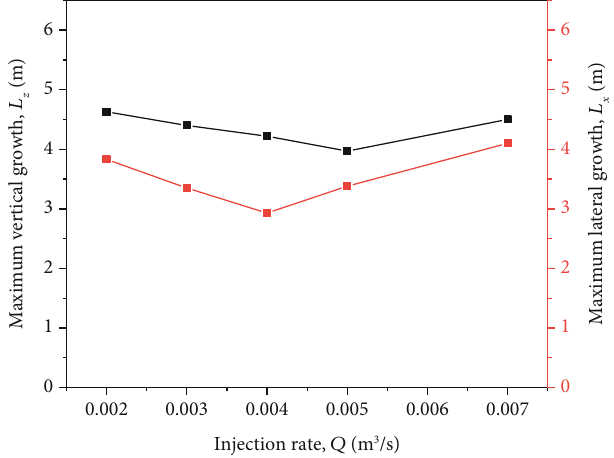
Figure 12: Variations of the maximum vertical and lateral growth for di ff erent injection